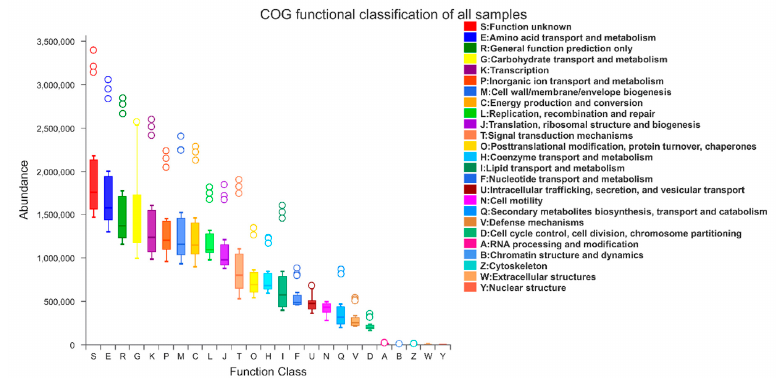
Figure 8. Clusters of Orthologous Groups (COG) functional classification of all samples. Level 2 COG functional annotation based on Phylogenetic Investigation of Communities by Reconstruction of Unobserved States (PICRUSt) of larval guts, pupal guts, pupal chamber tissues, and larval gallery tissues. The functions are represented by different colors.